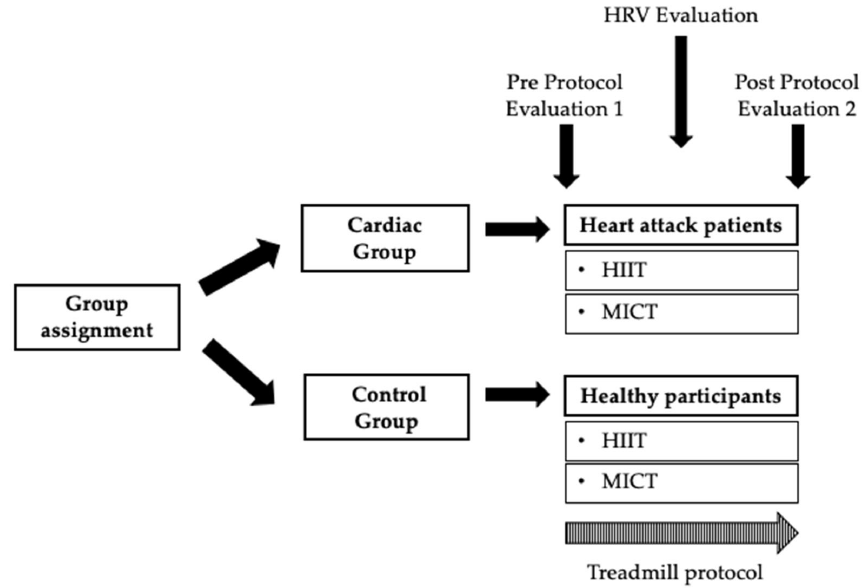
Figure 1. Summary of the present study protocol. HRV—Heart Rate Variability; HIIT—High-Intensity Interval Training; MICT—Moderate-intensity Continuous Training.